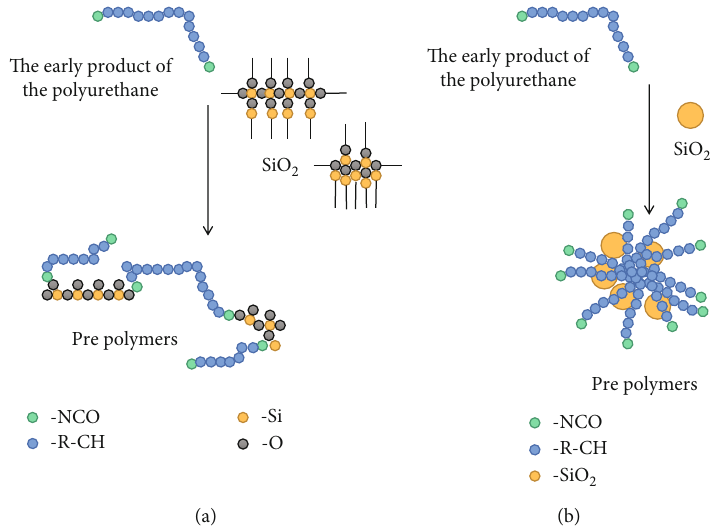
Figure 8: Schematic diagram of nanosilica/polyurethane: (a) hybridization and (b) doping.